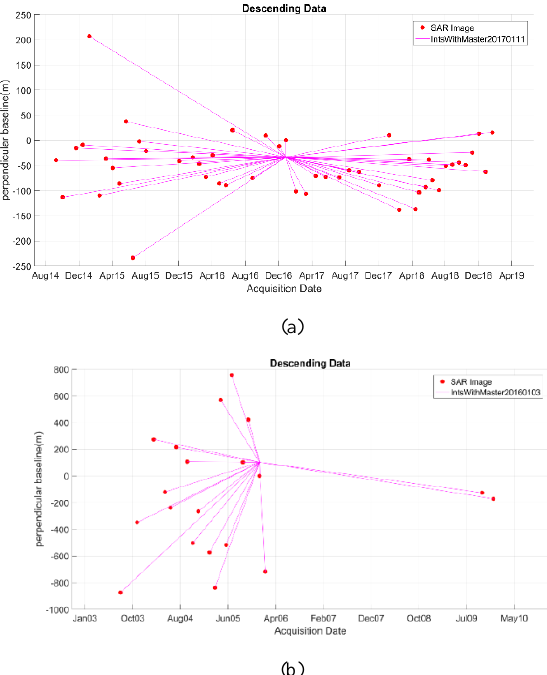
(b) Figure 6. Plots of acquisition dates versus perpendicular baselines for the final network of the (a) S1 descending, (b)